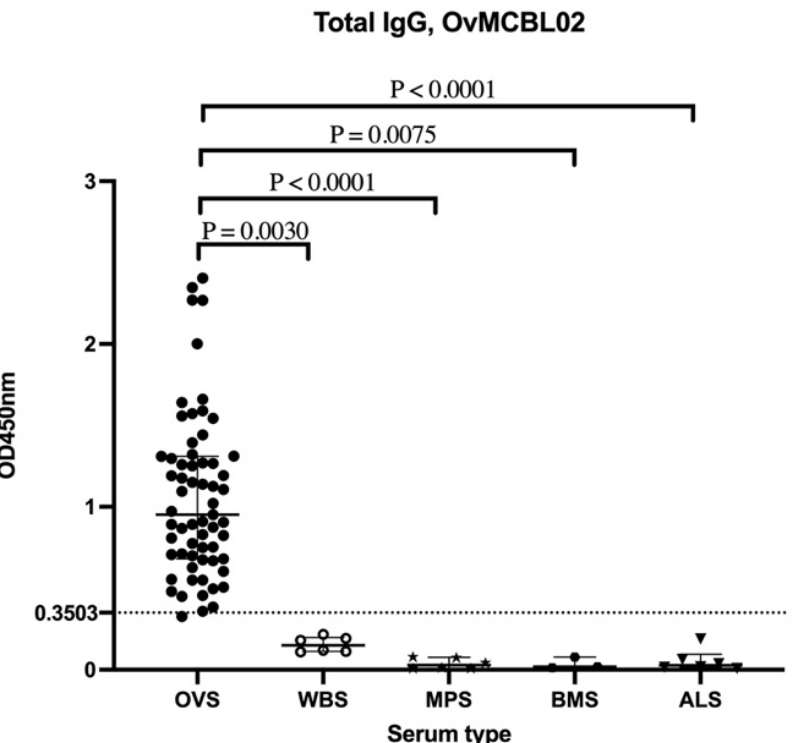
Figure 4. Evaluation of the humoral immune responses of related nematode sera to the OvMCBL02 multiepitope antigen. O. volvulus sera (OVS, n = 63), Wuchereria bancrofti sera (WBS, n = 6), Mansonella perstans sera (MPS, n = 6), Brugia malayi sera (BMS, n = 3) and Ascaris lumbricoides sera (ALS, n = 6). 3.6. Total IgG, IgG1, IgG2 and IgG3 but Not IgG4 Subclass Responded Positively to Kruskal–Wallis test followed by Dunn’s test were used for multiple comparisons among the groups.